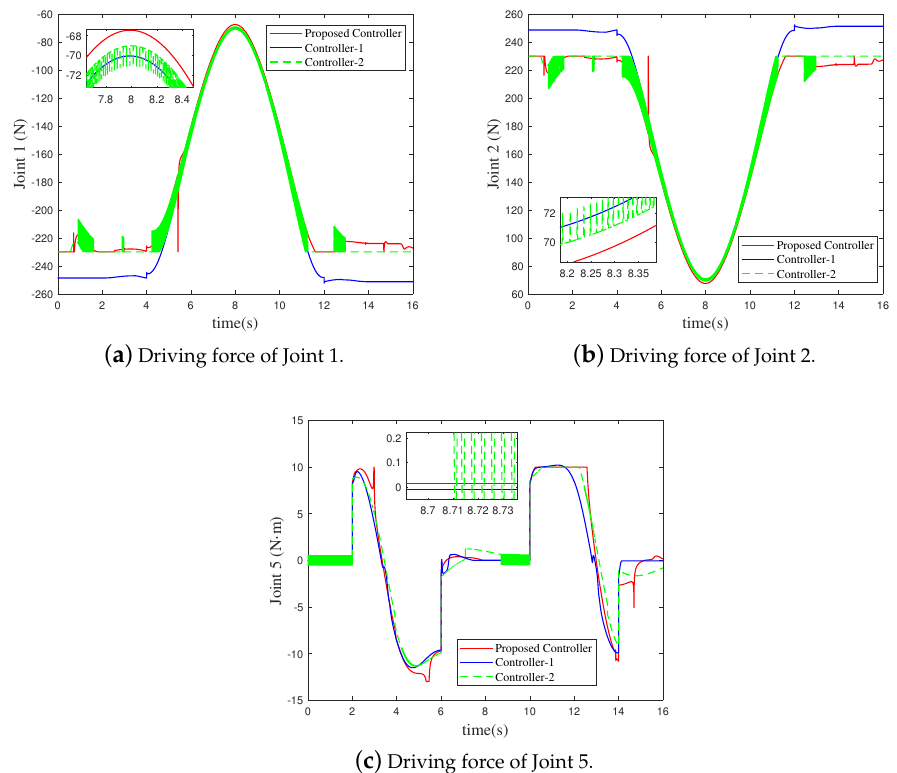
Figure 4. Tracking error curves of the unilateral active joints under the three controllers.